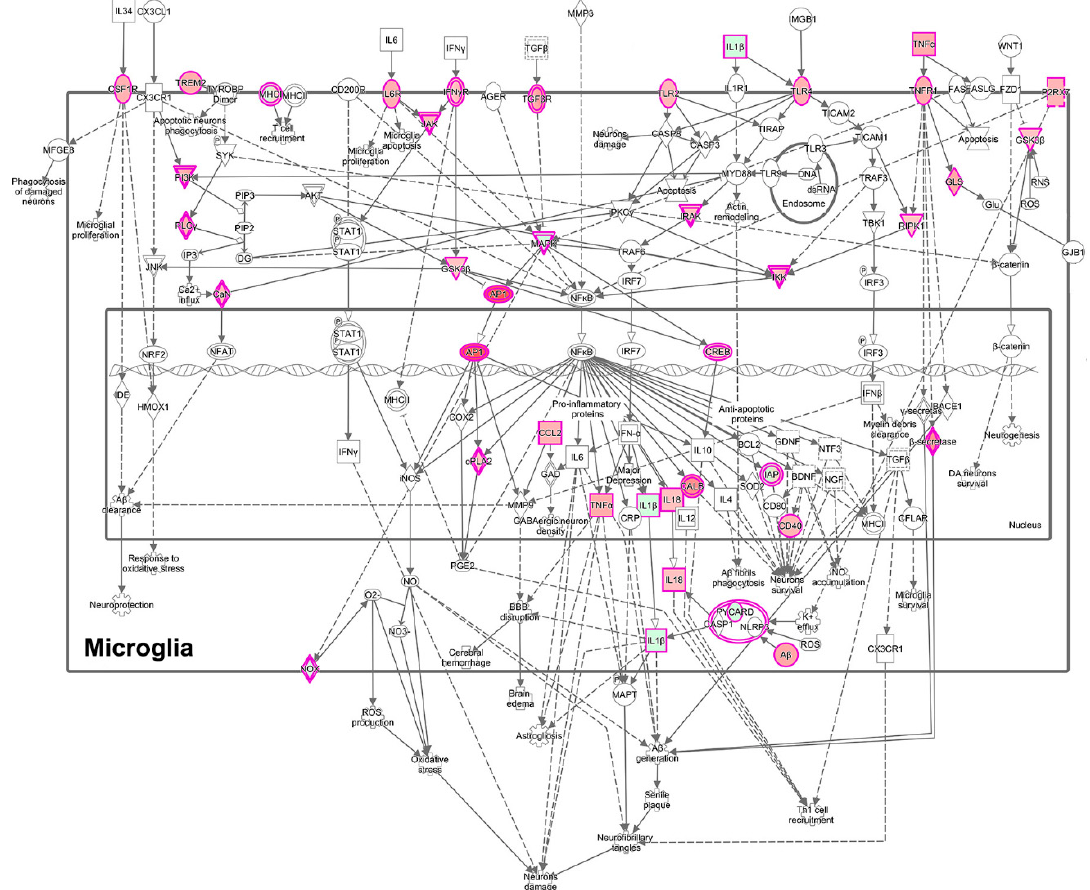
Figure 11. Enrichment of the neuroinflammatory pathway in microglia in cluster 1, based on the DEGs between cluster 1 and clusters 2–5. Cluster 1 is comprised predominately of cells from SIVE animals. The pink border indicates molecules with expression data, and the double border indicates a group or complex of molecules. Orange fill indicates increased expression, green decreased expression. Figure adapted from an IPA-generated